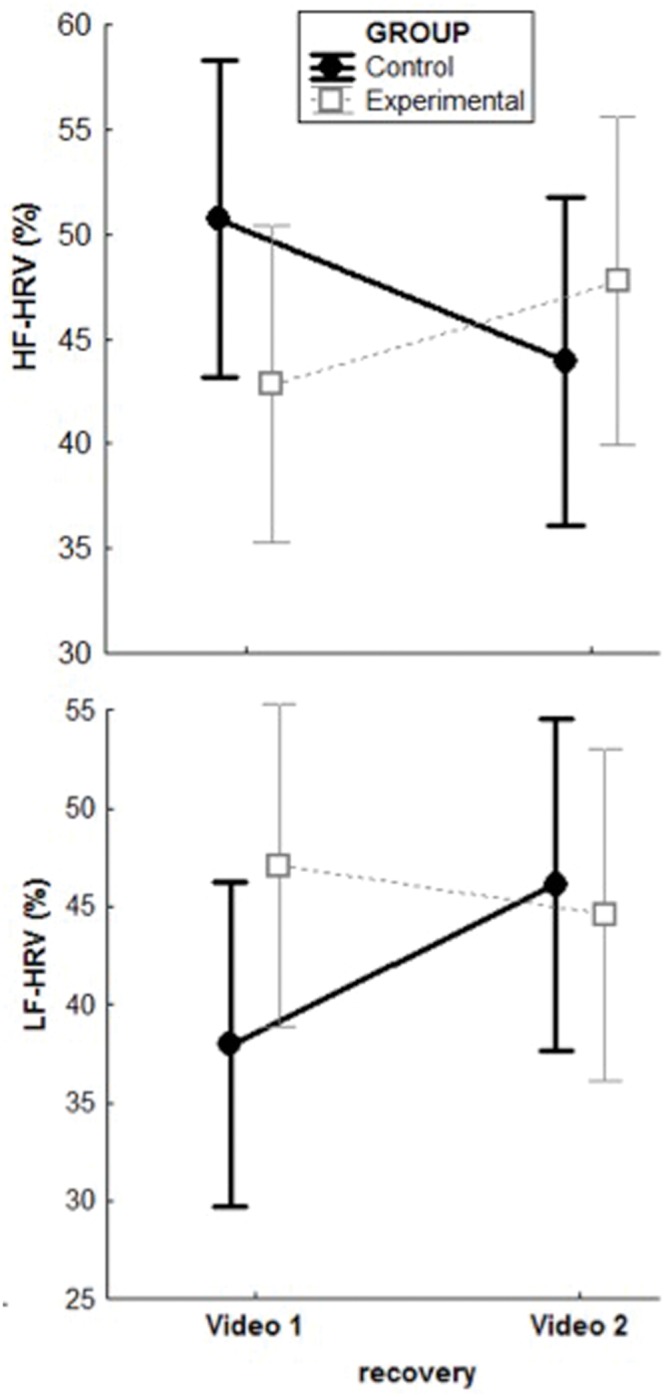
Group × Presentation interactions for HRV-related parameters after exposures to the videos, controlling for baseline levels.